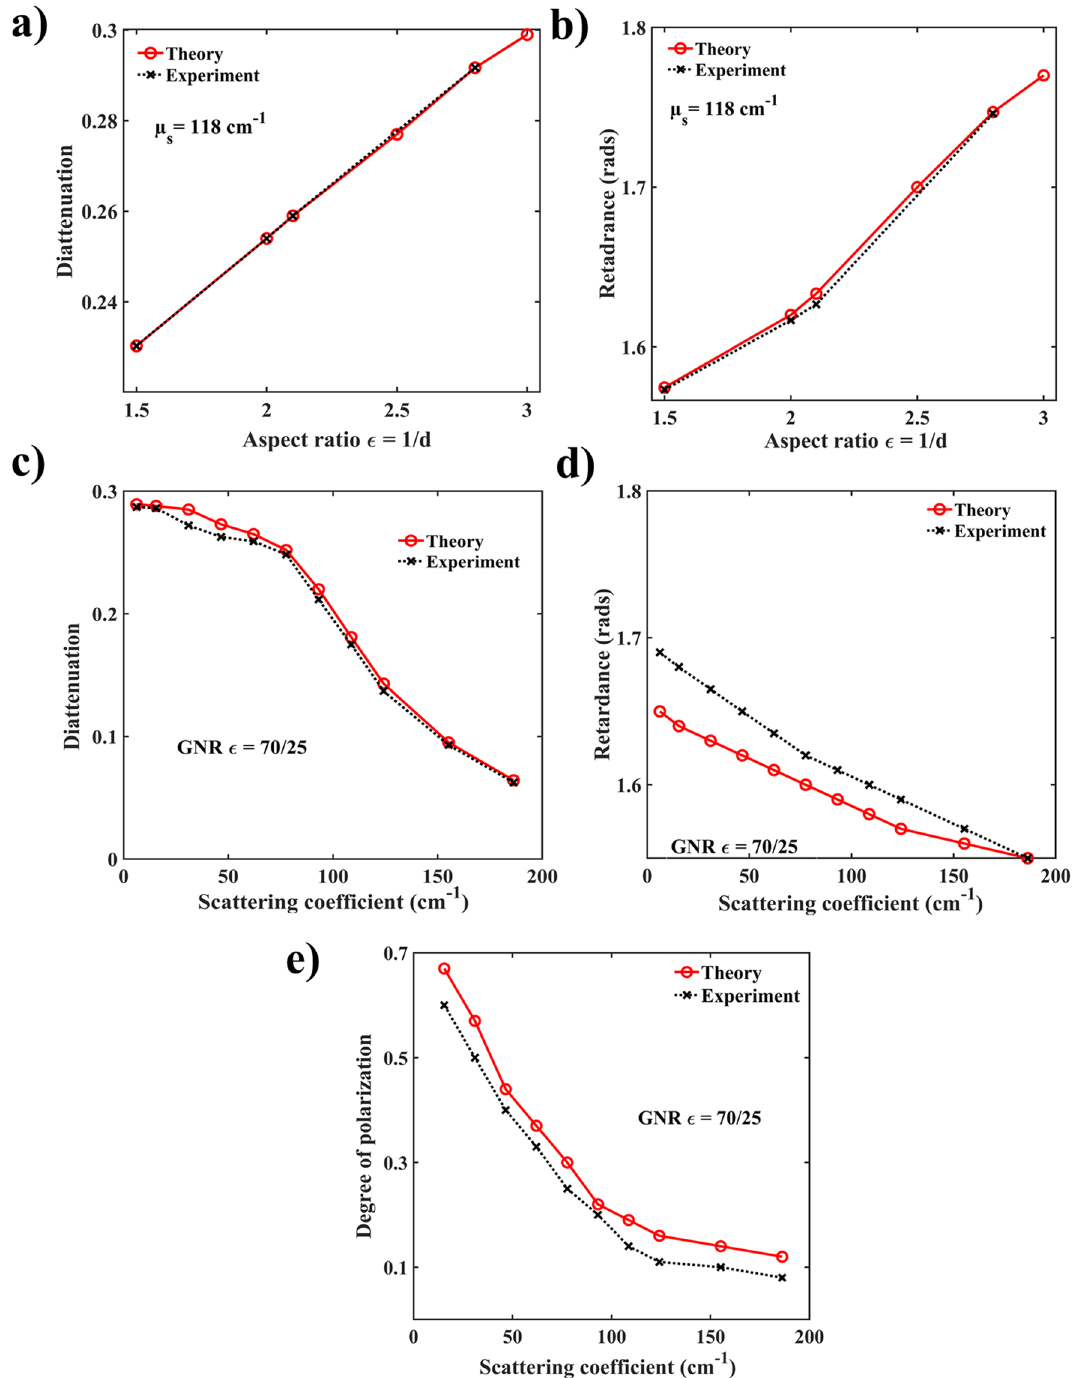
Figure 3. Polarization effects in a composite microsphere + GNRs phantom system. Mueller matrix simulated (red symbols) and experimentally obtained (black symbols) variation of the ( a ) diattenuation and ( b ) 1 102 cm retardance with GNR’s aspect ratio for a fixed scattering coefficient of the composite system( µ − S = ∈ due to microspheres plus 16cm − 1 due to GNRs). Increasing diattenuation and retardance with aspect ratio suggests size-dependent increase of the optically anisotropic nature of GNRs. Simulated (red symbols) and experimental (black symbols) variation of diattenuation and retardance with GNRs concentration in a turbid 1 ). The geometrical 102 cm phantom of fixed microsphere scattering properties (diameter = 0.42 µ m, µ S − = 70nm diameter d 25nm (aspect ratio 2.8 ). Both D and R exhibit parameters of GNRs were length l = = ∈= 1 ), implying strong 16cm significantly higher values (better contrast) at lower nanorod concentrations ( µ S − = orthogonal dipolar plasmon polarizabilities even for 3D random orientations of GNRs (for details, see text). The corresponding variation of the simulated and experimental degree of polarization on the GNR concentration shown in ( e